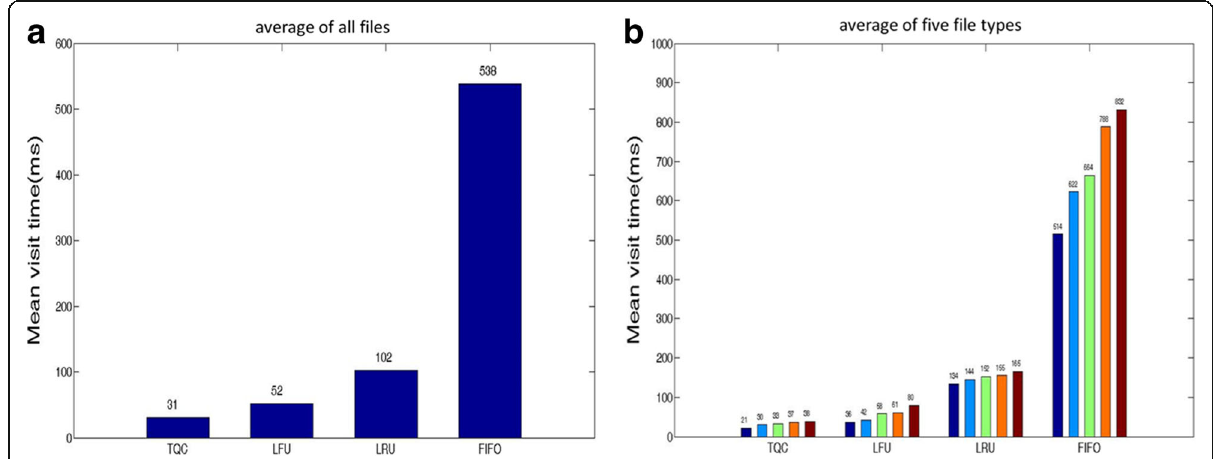
Fig. 6 File average access time. a The average response time for four cache policies to retrieve all files. It can be seen that TQC is better than LFU and LRU, and FIFO is the worst policy. b The average access time of five file types. The average response time of FIFO for all objects is the highest. And the time cost of LFU and TQC is the smallest. However, TQC has five types whose response time is not more than 50 ms, LFU has two while LRU has none. TQC can eventually achieve a stable state for each file after a long time of learning